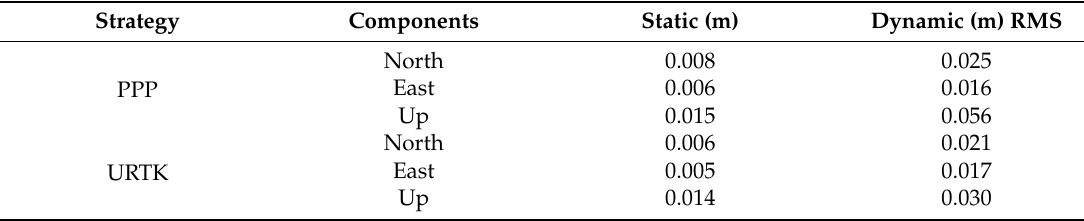
Table 3. Statistics of the positioning accuracy.